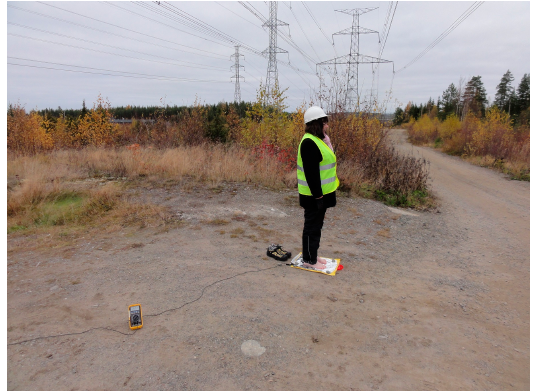
Figure 5. Measurements with normal clothes.